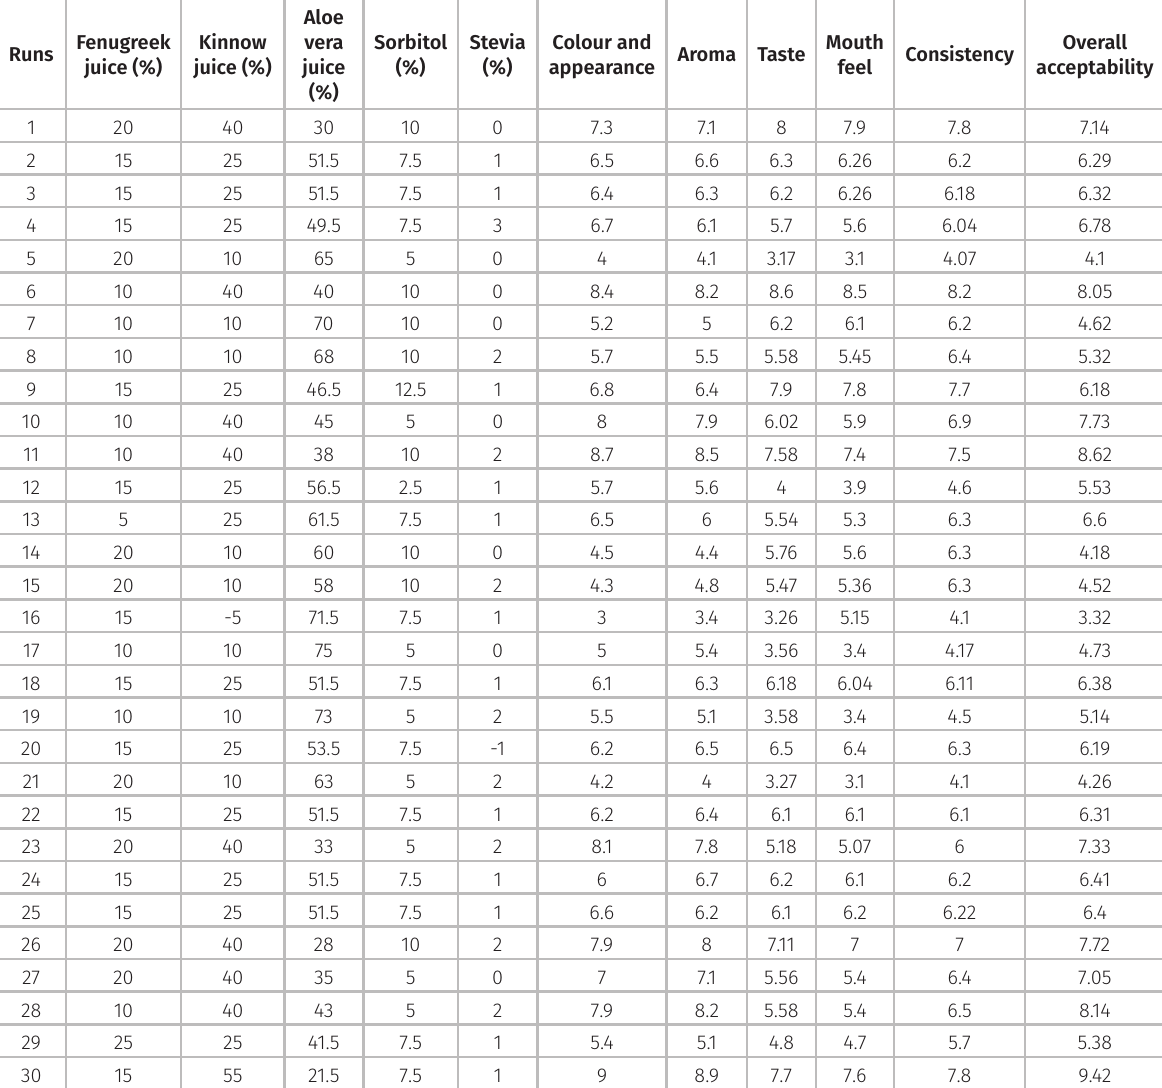
Table I. Sensory properties of microgreen based functional juice in response surface methodology. Aloe Fenugreek Kinnow Runs juice (%) juice (%)